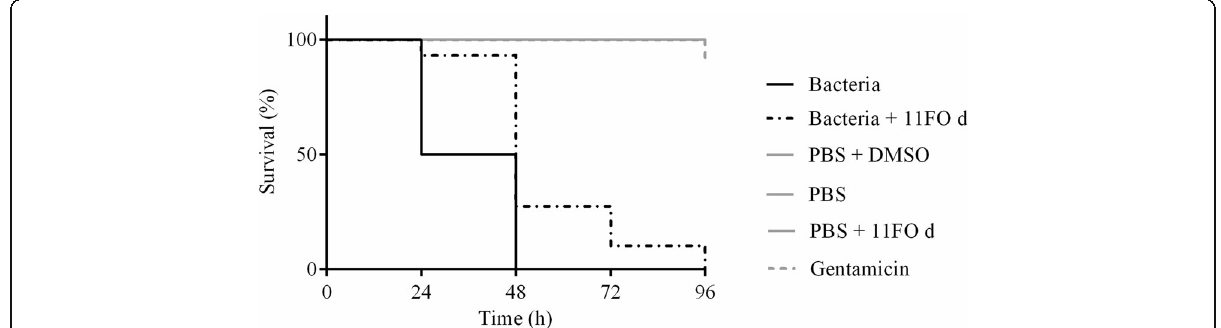
Fig. 7 Survival of Galleria mellonella inoculated with Staphylococcus aureus ATCC 29213. Larvae were treated with 200 mg/kg 11FO d at 96 h after infection. **** p < 0.0001, significantly different from the control